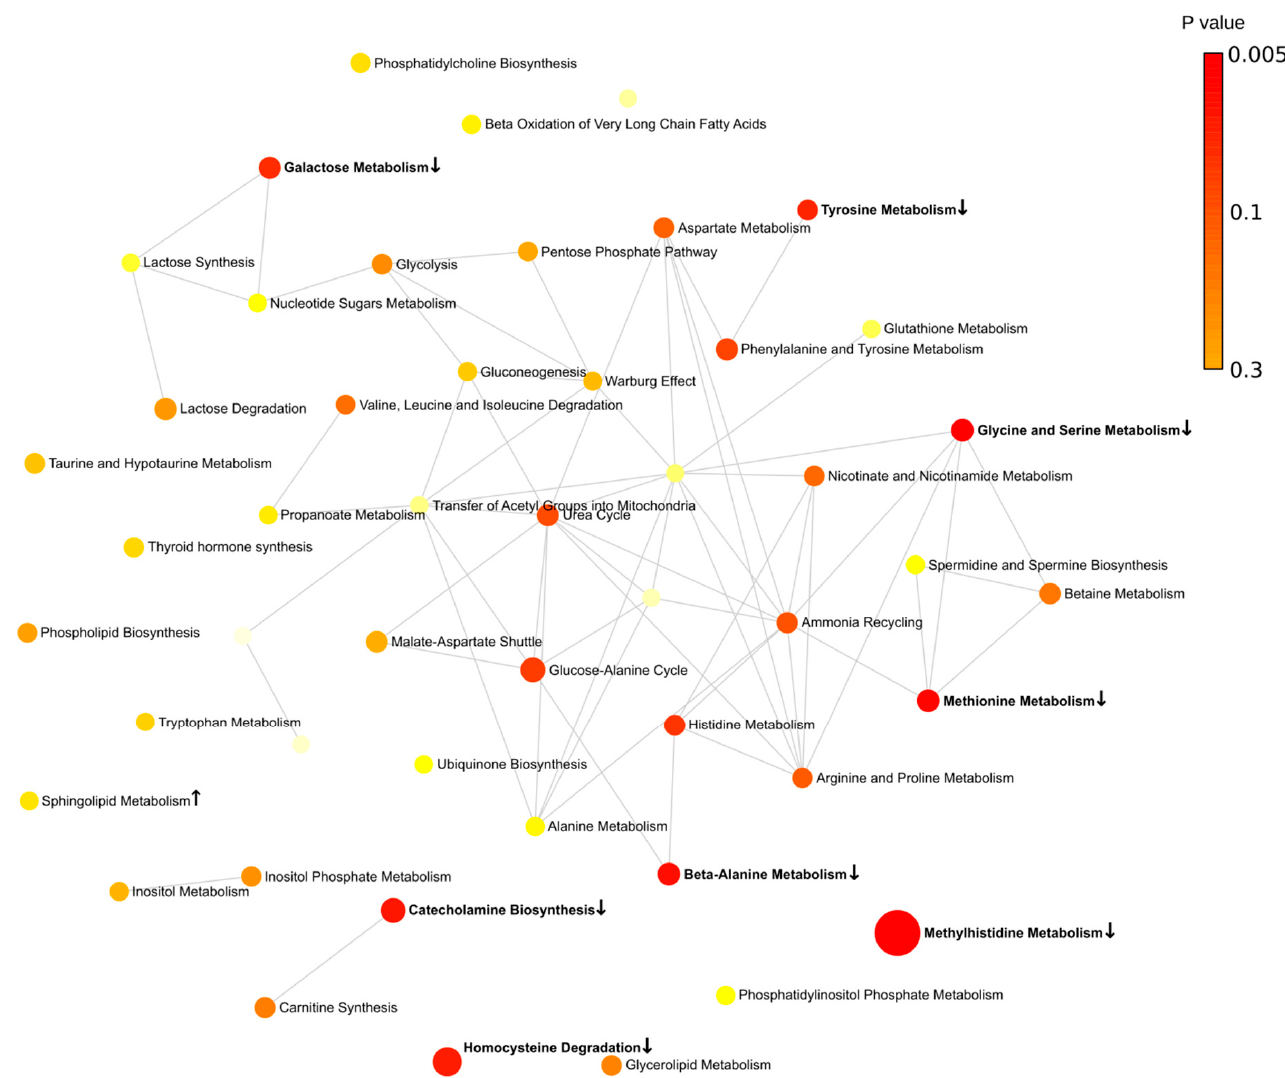
Figure 7. Metabolic pathways enriched in fall. Bold indicates significantly enriched pathways ( p < 0.05). ↑ —increased serum level of metabolites included in the metabolic pathway in MS compared to control; ↓ —decreased serum level of metabolites included in the metabolic pathway in MS compared to control. Each node represents a metabolite set with its color based on its p value and its size based on fold enrichment. Two metabolite sets are connected by an edge if the number of their shared metabolites is over 25% of the total number of their combined metabolite sets. The yellow to red color gradient and larger size of the circle indicate lower p value.